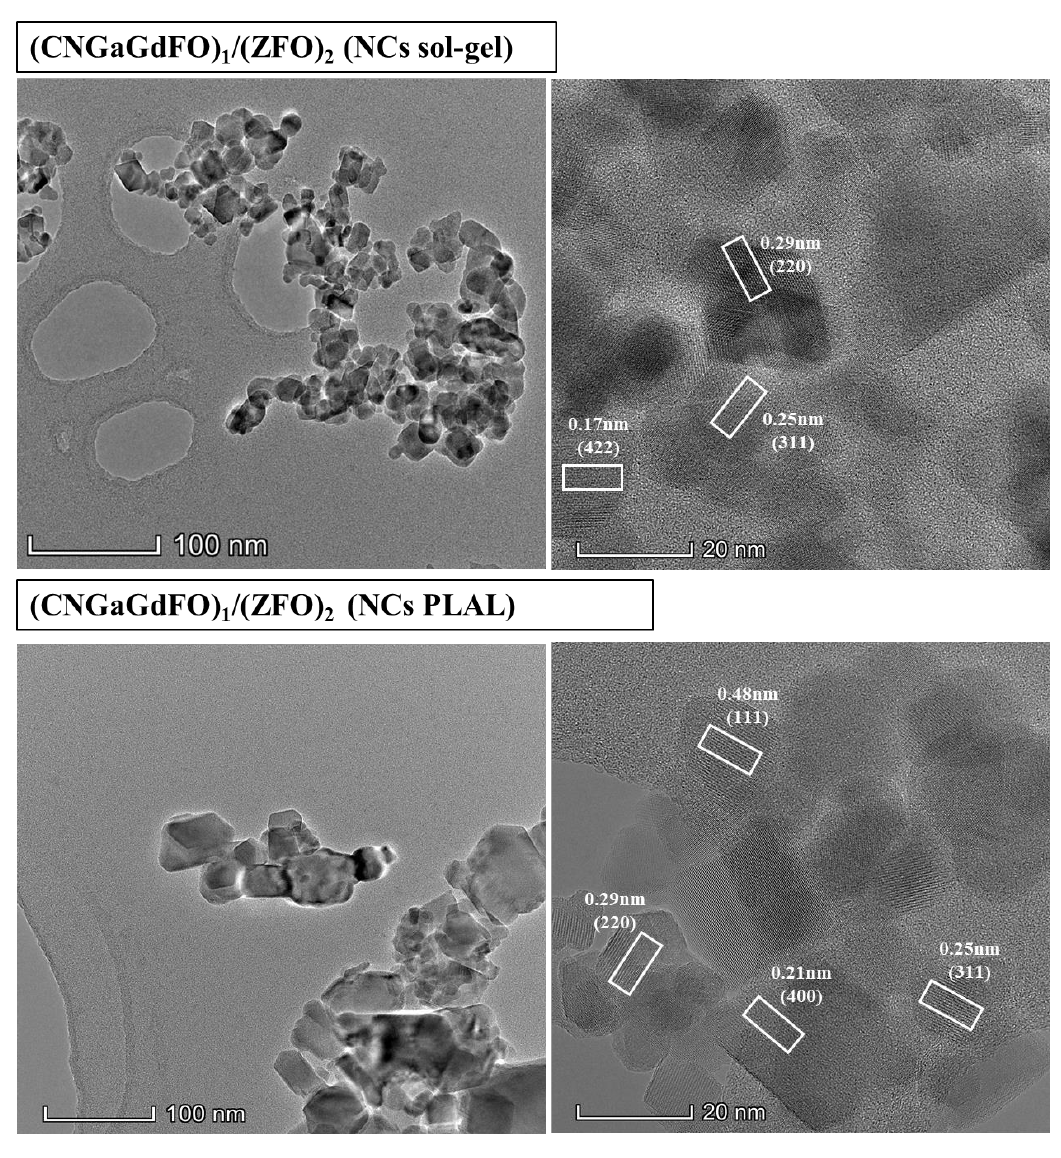
Figure 4. TEM and HR-TEM of (CNGaGdFO) x /(ZFO) y ( x:y = 1:2) NCs prepared by sol-gel and PLAL.